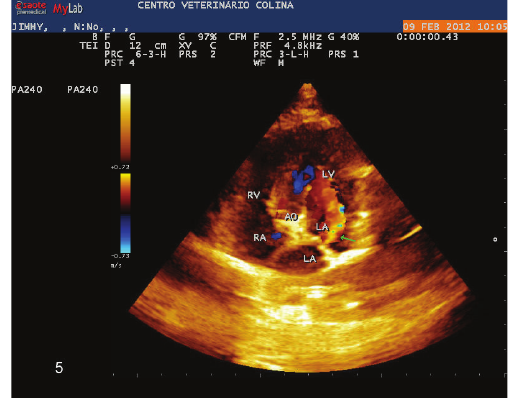
Figure 5: Transthoracic colour-Doppler echocardiogram (left api- cal four-chamber view) in diastole. Note a blood flow (green arrow) crossing a central orifice located in the intra-atrial membrane. Right atrium (RA), right ventricle (RV), left atrial chamber (LA), and aorta